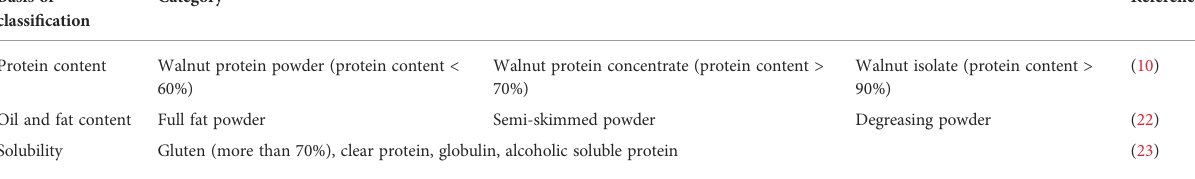
TABLE 1 Classi fi cation of Walnut protein